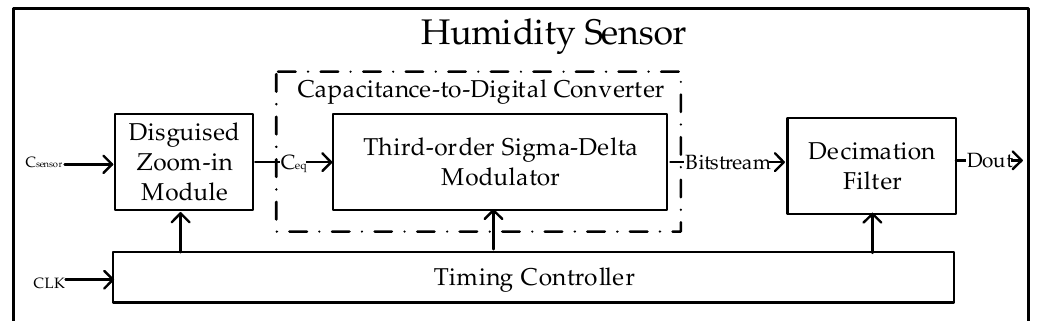
Figure 2. Overview of the analog-to-digital converter (ADC).